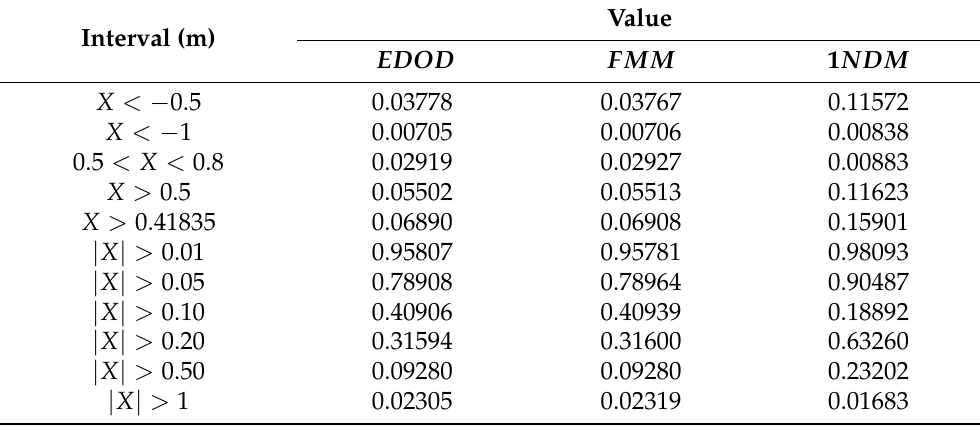
Table 4. Example of probabilities for several discrepancy intervals using de Finite Mixture Model ( FMM ), the One Normal Distribution Model (1 NDM ) and the empirical distribution of observed data ( EDOD